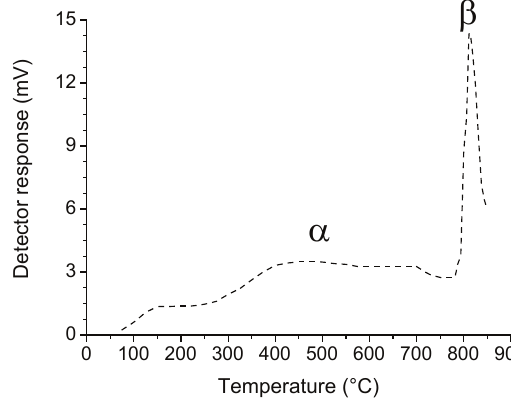
Sr CoO . The 0.6 0.4 3